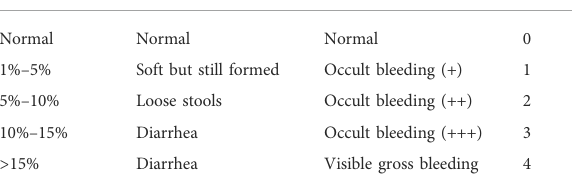
TABLE 2 Scoring of disease activity